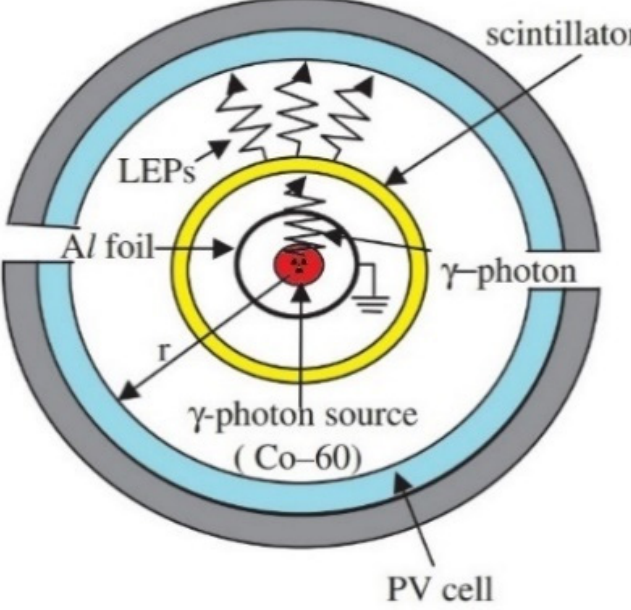
Figure 18. A spherical gamma ray photovoltaic cell (GRPVC) of radius r utilizes high-energy-photons that produce a large number of low-energy photons (LEPs) in the scintillator. The LEPs illuminate the PV cell of the device. Copyright permission from [152].